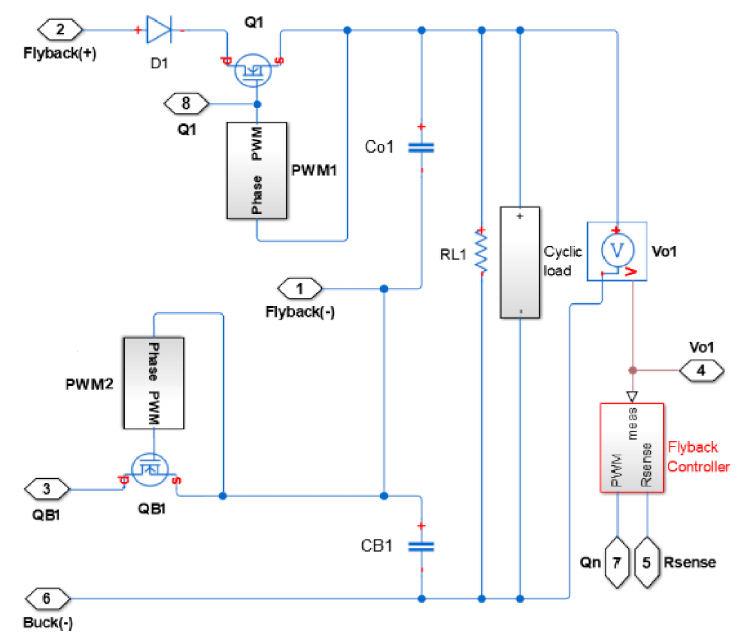
Figure 15. Expanded view of channel 1 showed in Figure 14.